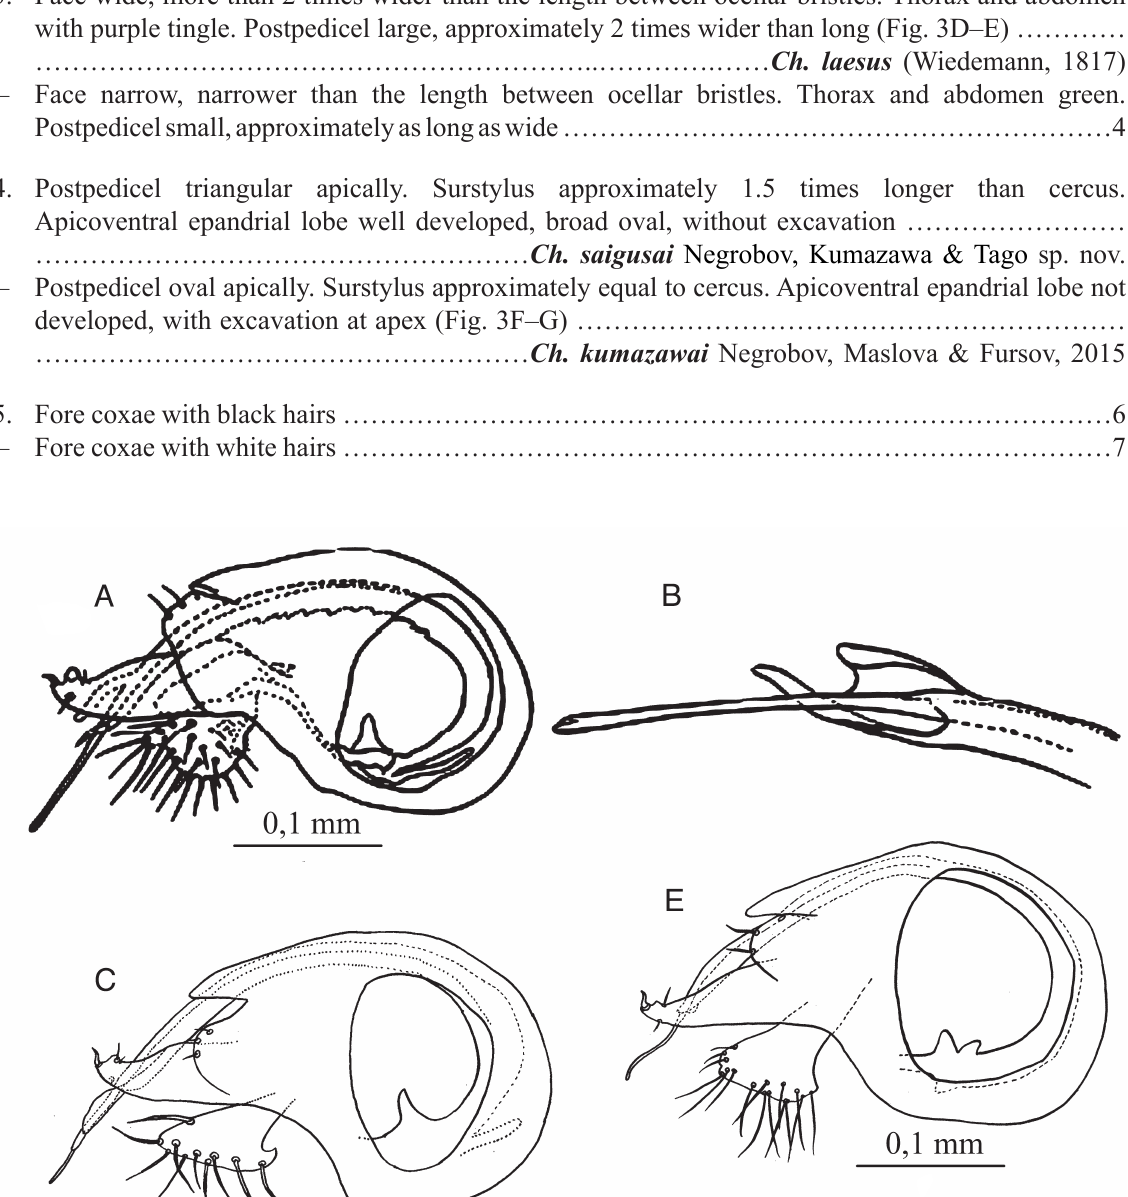
Face wide, more than 2 times wider than the length between ocellar bristles. Thorax and abdomen with purple tingle. Postpedicel large, approximately 2 times wider than long (Fig. 3D–E) ………… – Face narrow, narrower than the length between ocellar bristles. Thorax and abdomen green. 4. Postpedicel triangular apically. Surstylus approximately 1.5 times longer than cercus.